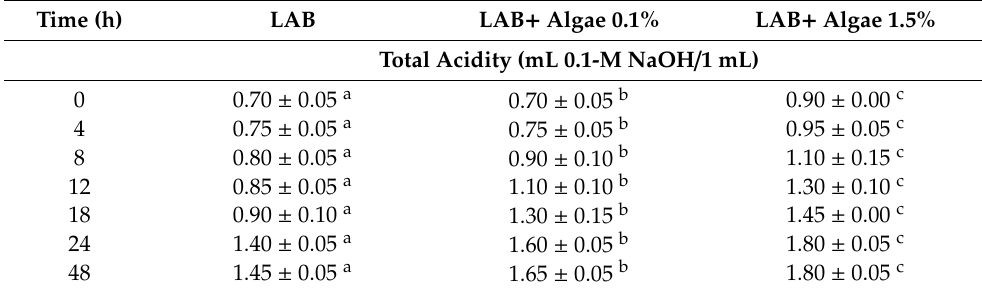
E ff ect of algae Chlorella vulgaris on the total titratable acidity of Lactobacillus brevis ŁOCK